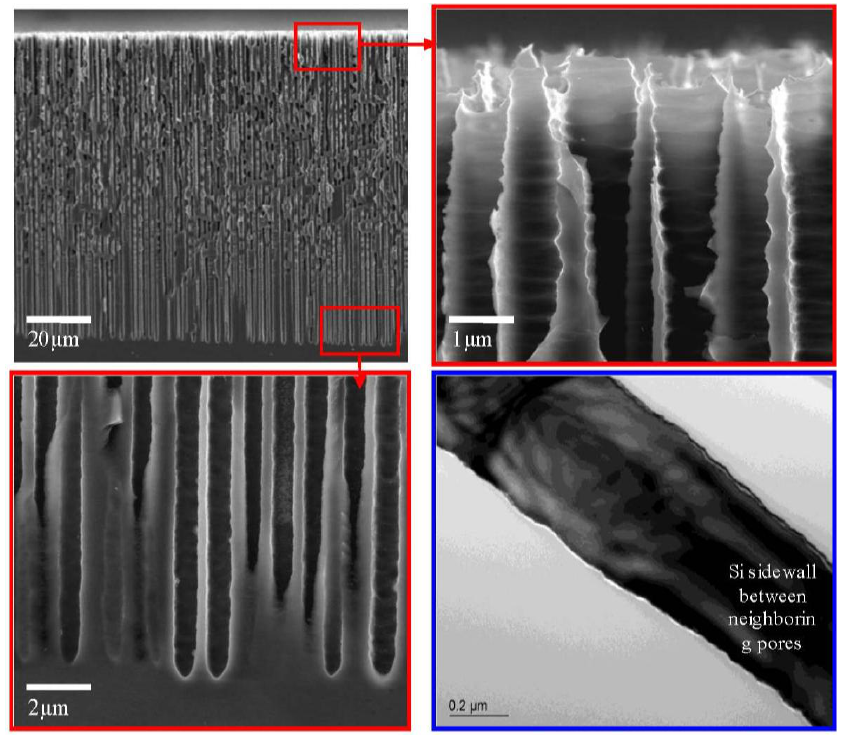
Figure 1. Field emission SEM (FESEM) and TEM (the lower right) micrographs of the macropores with high aspect ratio formed in p − Si. Anodization was conducted in a 8% Hydrofluoric Dimethyl Sulfoxide (HF DMSO) solution with current density of 8 mA/cm 2 applied in a two-electrode Teflon cell at room